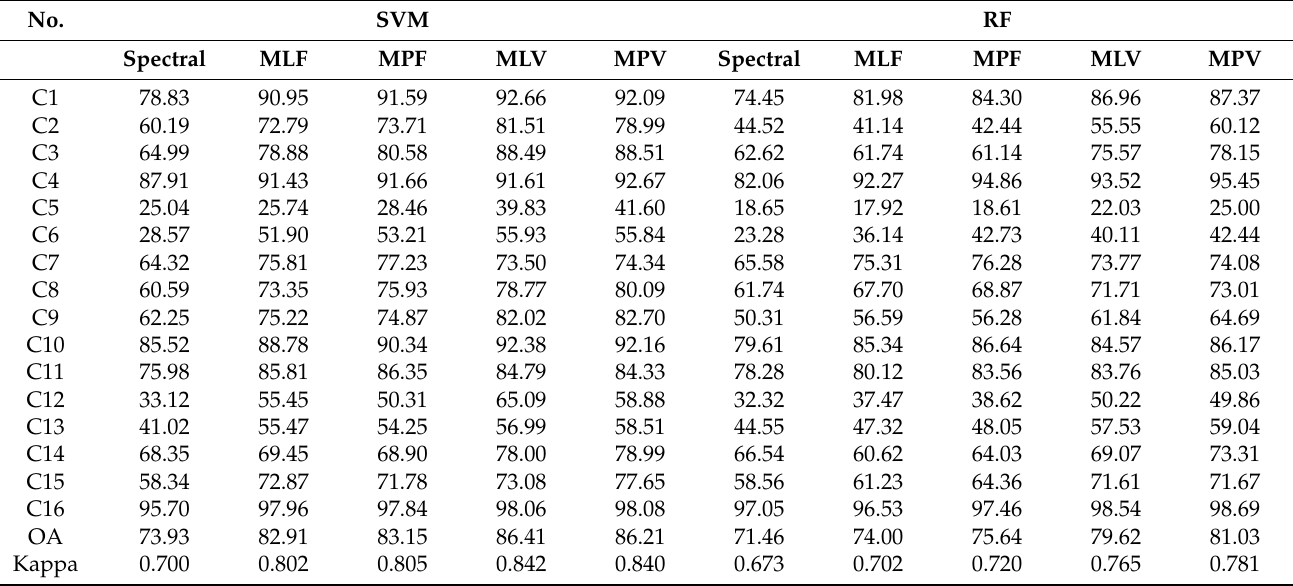
Table 11. Classification accuracies given by different methods for the Hanchuan dataset using SVM and RF with 100 training samples per